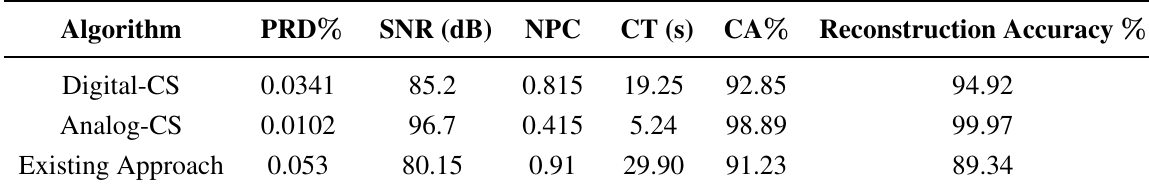
Table 10. Comparison on myopathy sEMG signals.